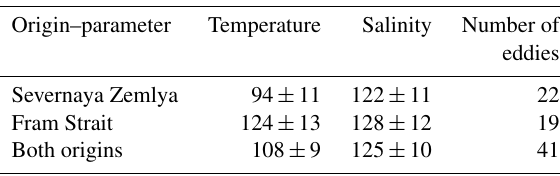
Table 1. Errors of eddy origin identification (in km) estimated us- ing differences between temperature and salinity in eddy cores and climatological